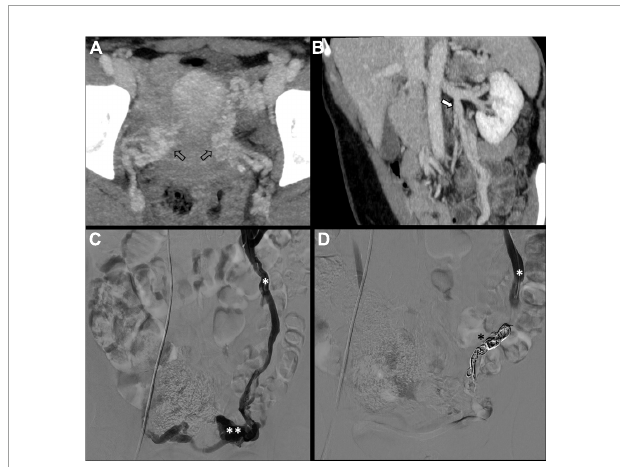
FIGURE2 Type Ia pelvic varices in a 48 yo female due to unilateral venous insufficiency. (A,B) Computed tomography (CT) phlebography shows pelvic varices (open arrows) with a dilated left ovarian vein (white arrow). (C,D) Conventional phlebography and CT phlebography show pelvic varices (double white asterisks) with a dilated left ovarian vein (single white asterisk), treated with multiple coils (single black asterisk).